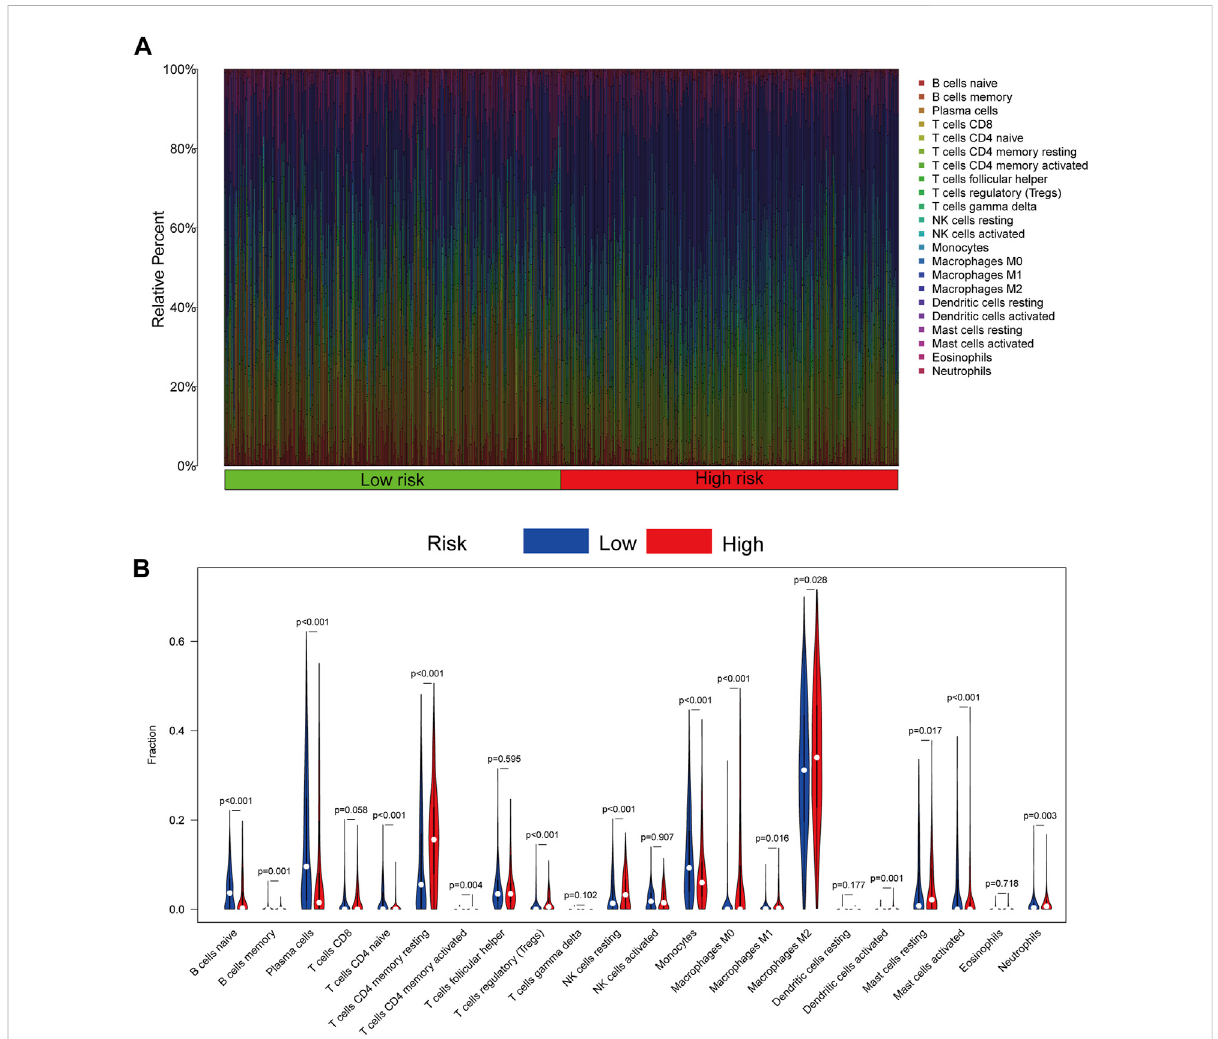
FIGURE 7 Immune cell in fi ltration of patients in the TCGA cohort by CIBERSORTx. (A) In fi ltration of 22 kinds of immune cells from patients in the TCGA cohort. (B) In fi ltration of 22 kinds of immune cells in patients with high- and low-risk scores. p < 0.05 was considered a threshold of statistical signi fi